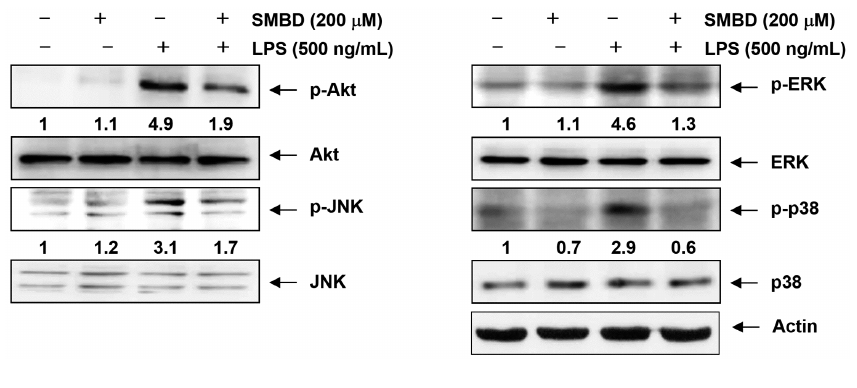
Figure 6. Effects of SMBD on the activation of MAPKs and PI3K/Akt pathways induced by LPS in BV2 microglia. BV2 cells were treated with 200 μ M SMBD 1 h prior to treatment with 500 ng/mL LPS for 1 h. Whole cell lysates were prepared and were subjected to 10% SDS-polyacrylamide gels, followed by Western blot analysis using the indicated antibodies. Actin was used as internal control for the Western blot analysis. The numbers represent the average densitometric analyses as compared with actin in, at a minimum, two or three different